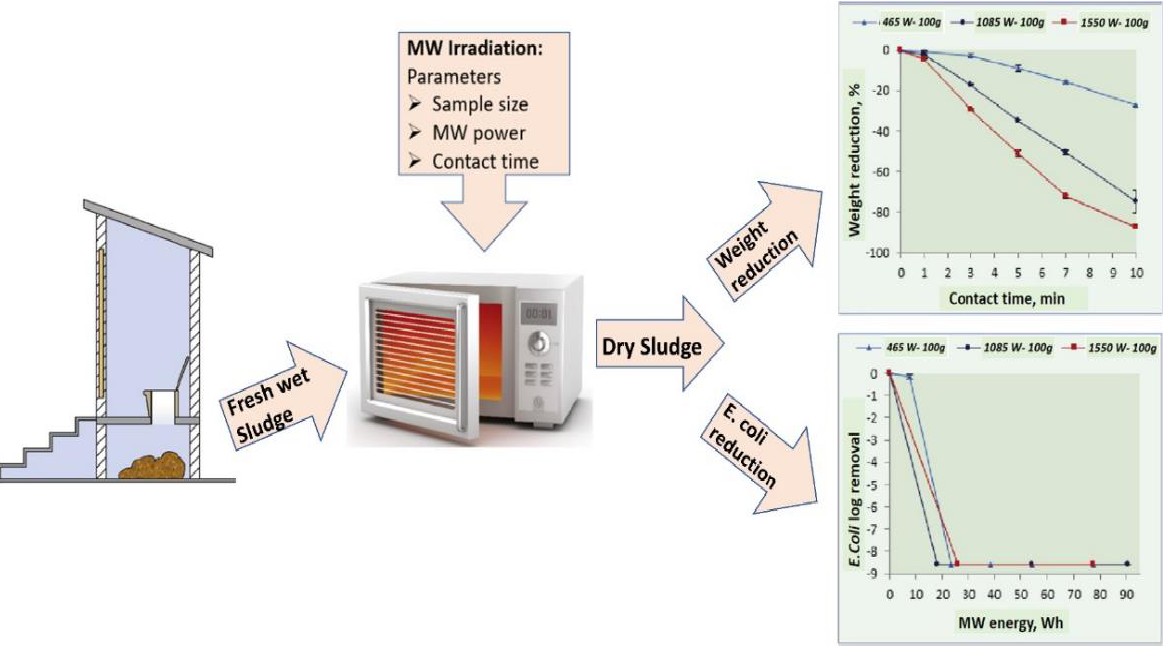
Figure 10. Diagrammatic representation of the process implementing the usage of domestic MW for the reduction in BW sludge volume and the pathogen reduction in the treated sludge. The above figure was adapted from the work of Peter M. Mawioo et al. Reused under the Creative Commons license agreement (CC BY 4.0) [57] .